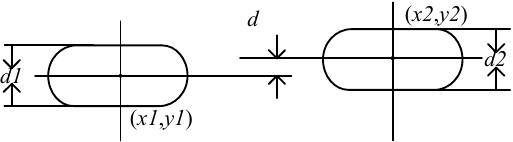
Figure 11. Symmetry condition in the vertical direction.